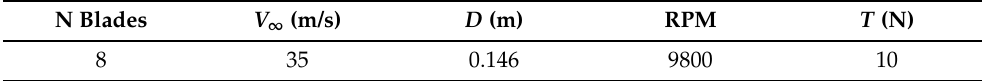
Table 3. Assigned XROTOR input data.